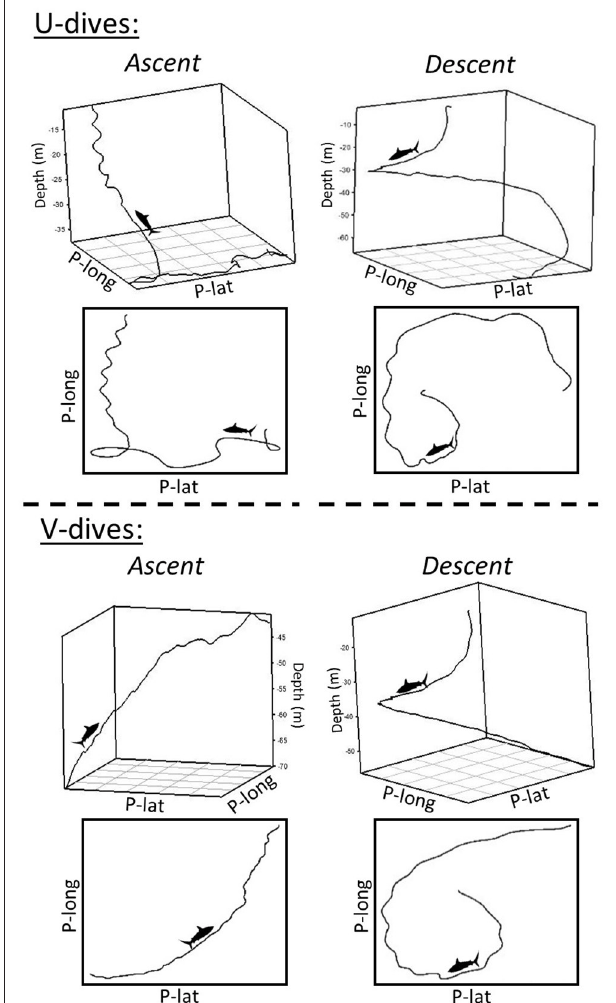
FIGURE 6 | Five minute 3D tracks and pseudo-tracks of turning behavior throughout the ascents and descents of U-shaped dives and V-shaped dives. X and Y axes represent arbitrary units of latitude (P-lat) and longitude (P-long) as they were created by dead-reckoning using magnetometer and accelerometer data assuming a constant speed. The Z axes in the 3D plots represents depth